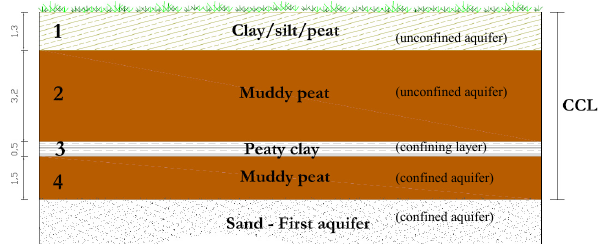
Fig. 8. Schematization of the CCL.